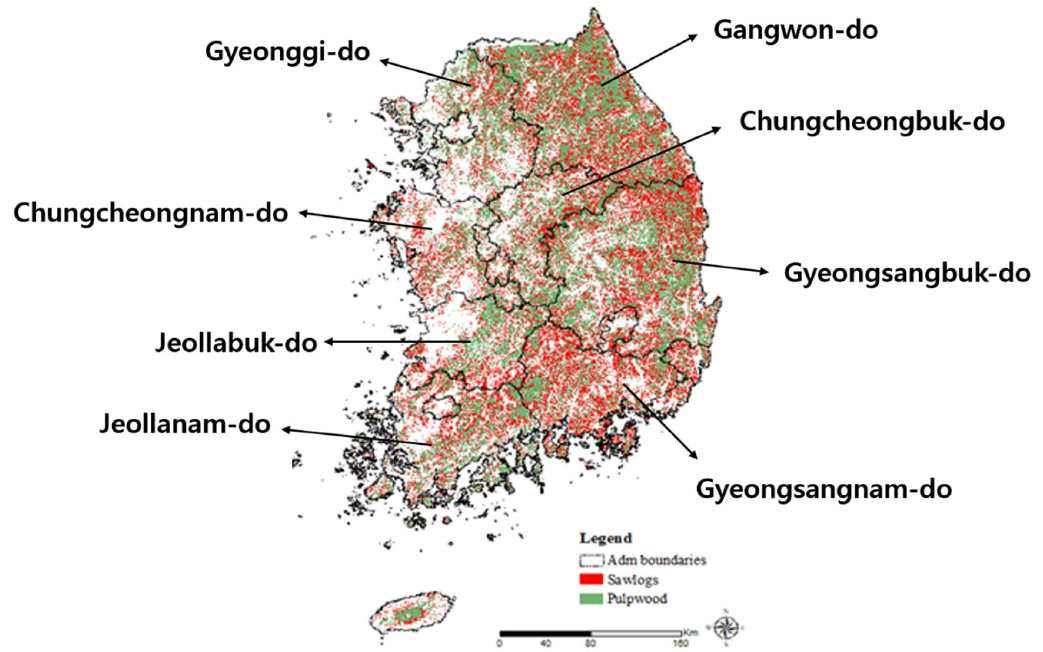
Forests 2020 , 11 , x FOR PEER REVIEW Figure 3. Forecast map of the national ‐ level forest resource availability. Figure 3. Forecast map of the national-level forest resource availability.